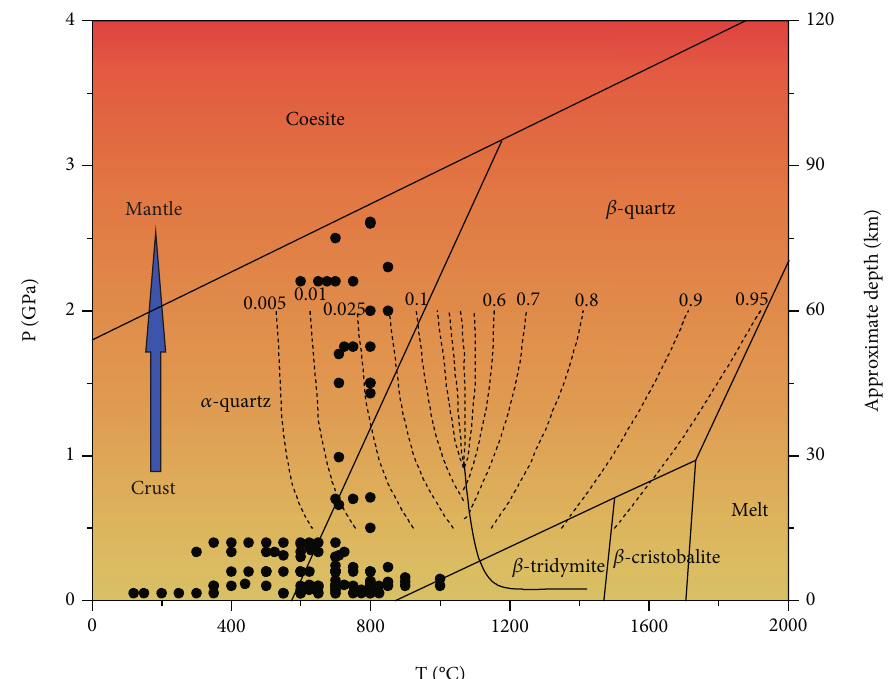
Figure 4: Temperature and pressure plots of some typical applications of the FIS techniques. Notes: black solid circles show the temperature and pressure conditions of the typical experiments for fl uid inclusion synthesis. The related temperature and pressure data are mostly from literatures listed in Tables 1 – 5 and in the reference list [30, 36, 43, 44, 47]. Dashed lines are the isopleths of the quartz solubility in pure water, and the values are expressed mole fraction [106]. The heavy solid line represents the wet quartz melting curve according to Kennedy et al. [107]. The phase diagram of silica is modi fi ed after Ford et al. [108] and Mao et al.